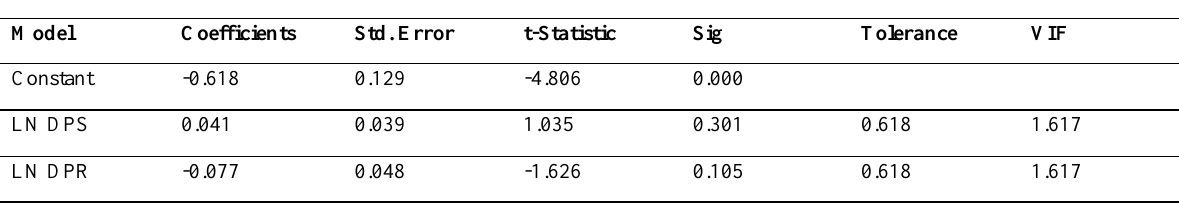
Table 5: Regression Result Test